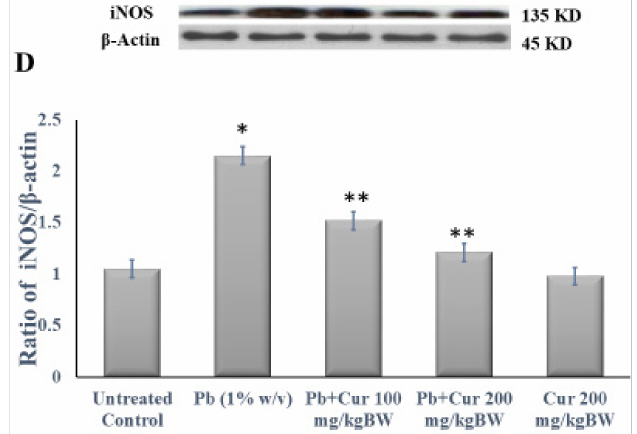
Figure 5. Effect of curcumin on inflammation caused by lead. ( A ) TNF- α level in plasma. ( B – D ) expressions of TNF- α , COX-2, and iNOS in brain homogenate, respectively. The results are displayed as mean ± SEM ( n = 6). * p < 0.05 specifies the differences between control mice and Pb-treated mice. ** p < 0.05 compares between Pb-treated mice and curcumin (Cur)-treated mice. Table 3. Curcumin attenuates oxidative stress, inflammation, and acetylcholinesterase dysfunction via interacting with AChE, COX-2, TNF- α , IKK, ERK, p38, and JNK. Compound Protein PDB ID Docking Score Glide e-Model Glide Energy